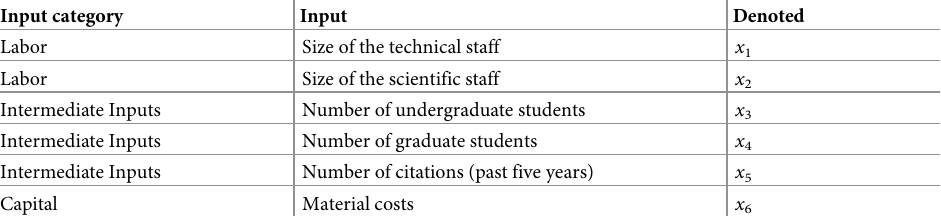
Table 2. Dimensions of input and the variables used to operationalize the